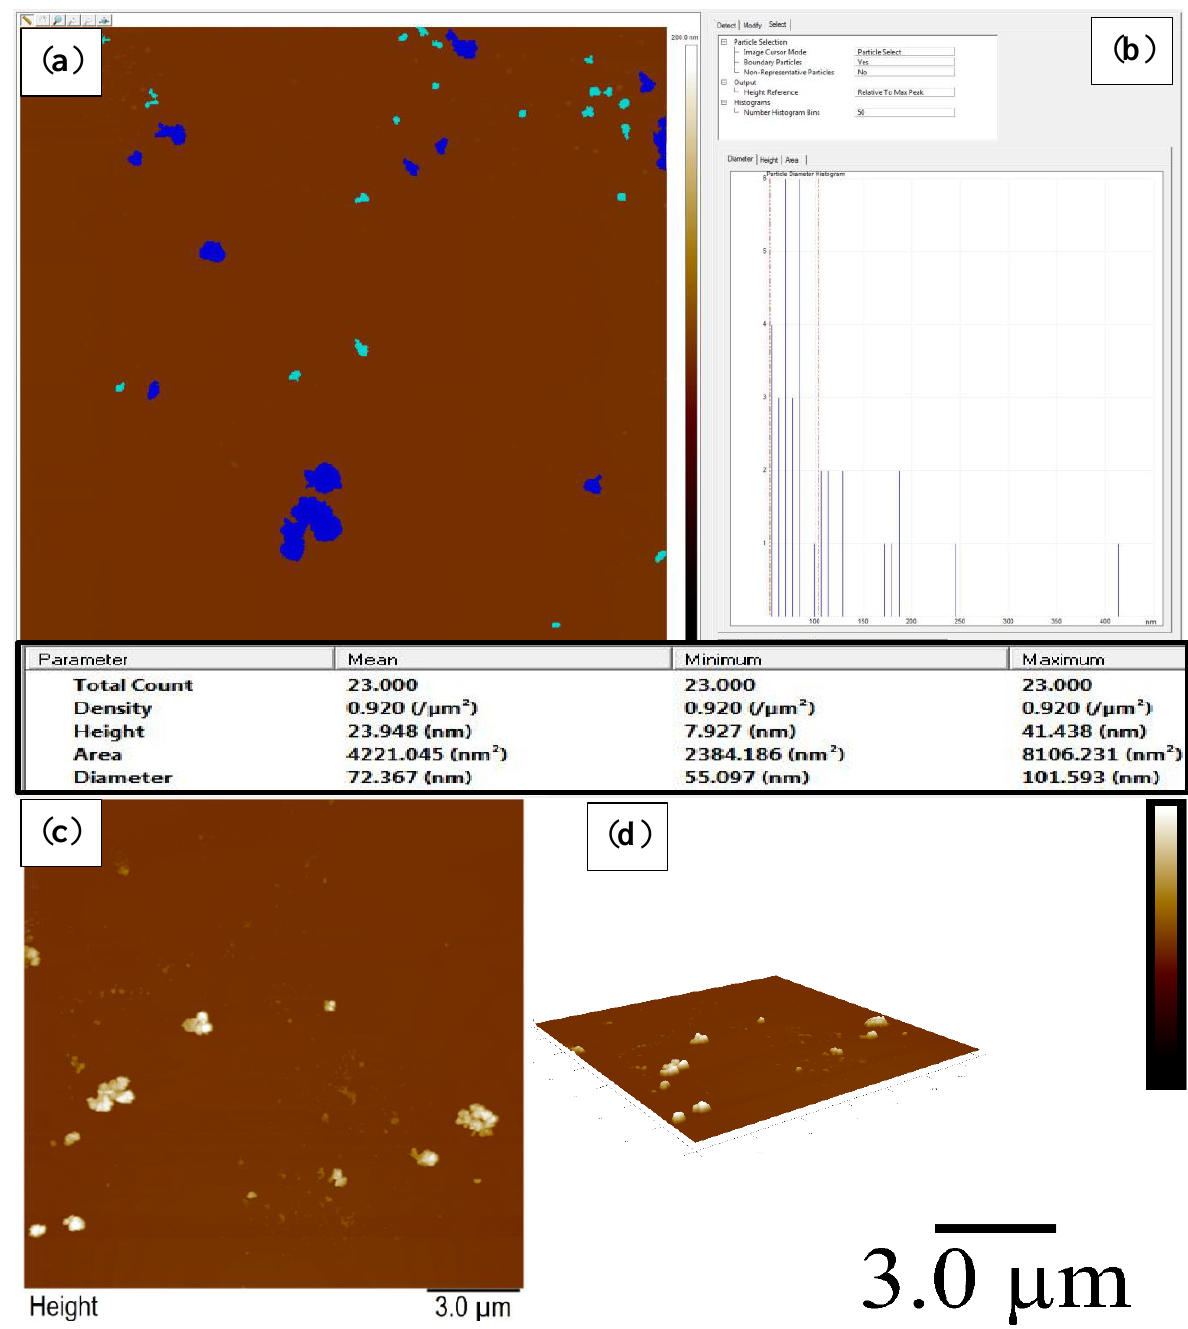
Figure 5. Selected area ( a ), histogram ( b ), 2-D ( c ), and 3-D ( d ) AFM micrographs of SnO 2 NPs.